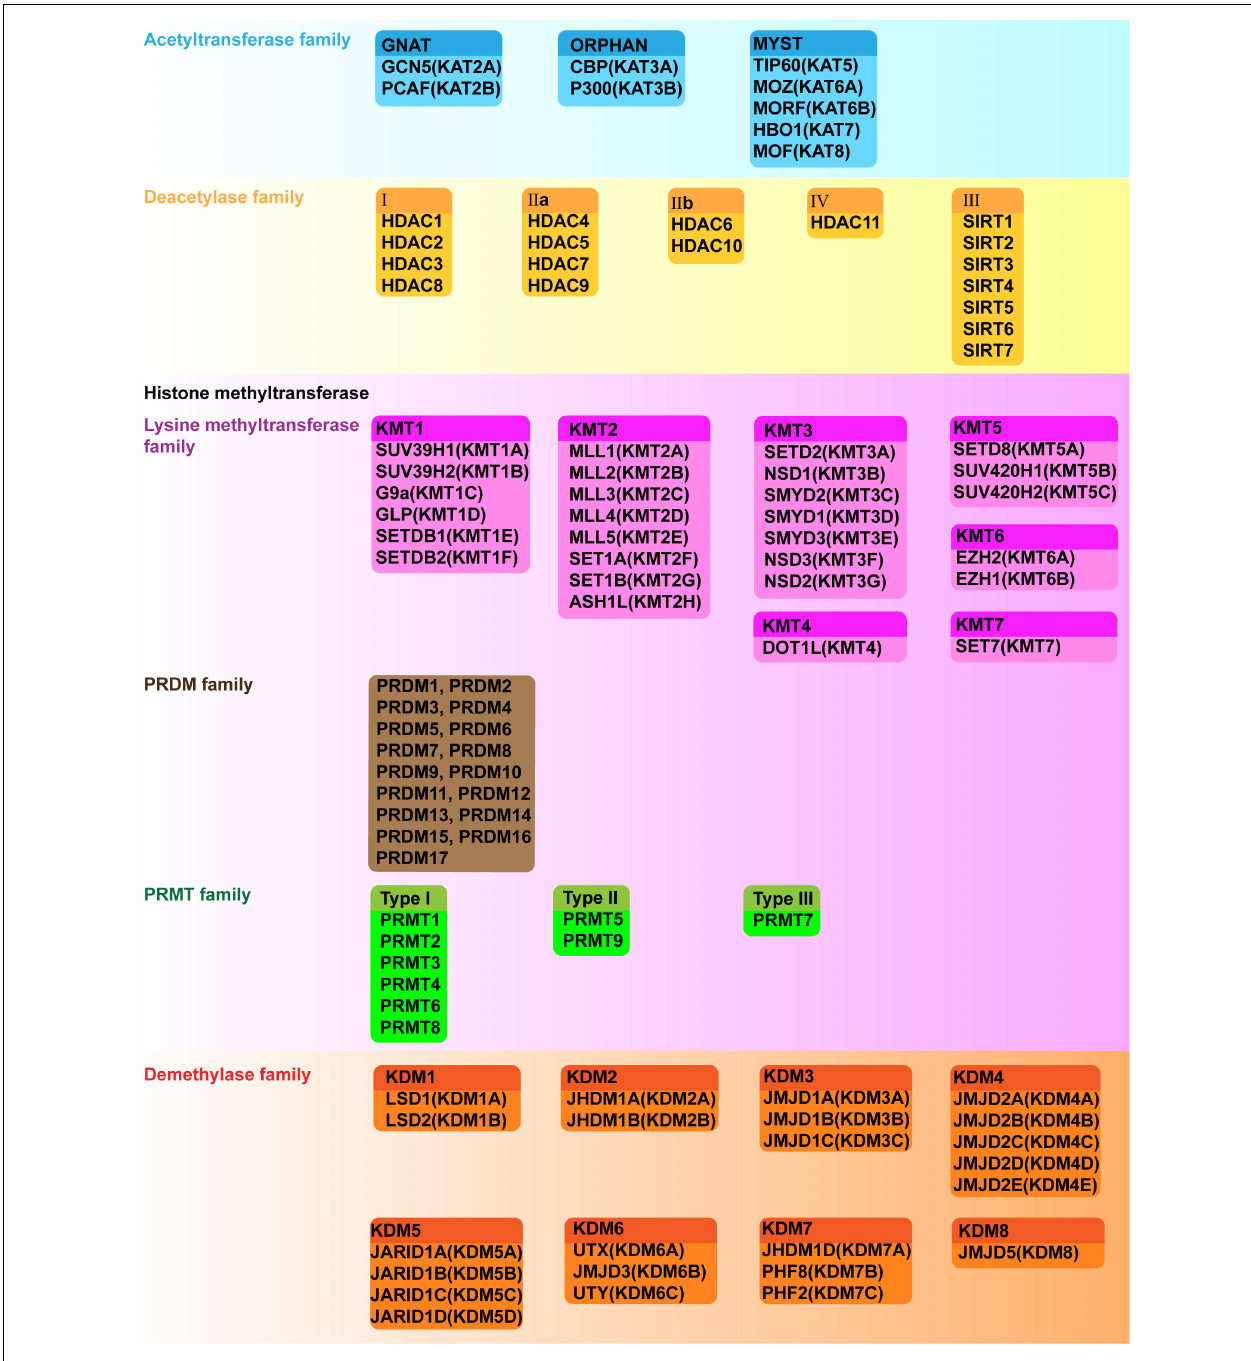
FIGURE 2 | Classification, formal names and aliases of HATs, HDACs, HMTs and KDMs.